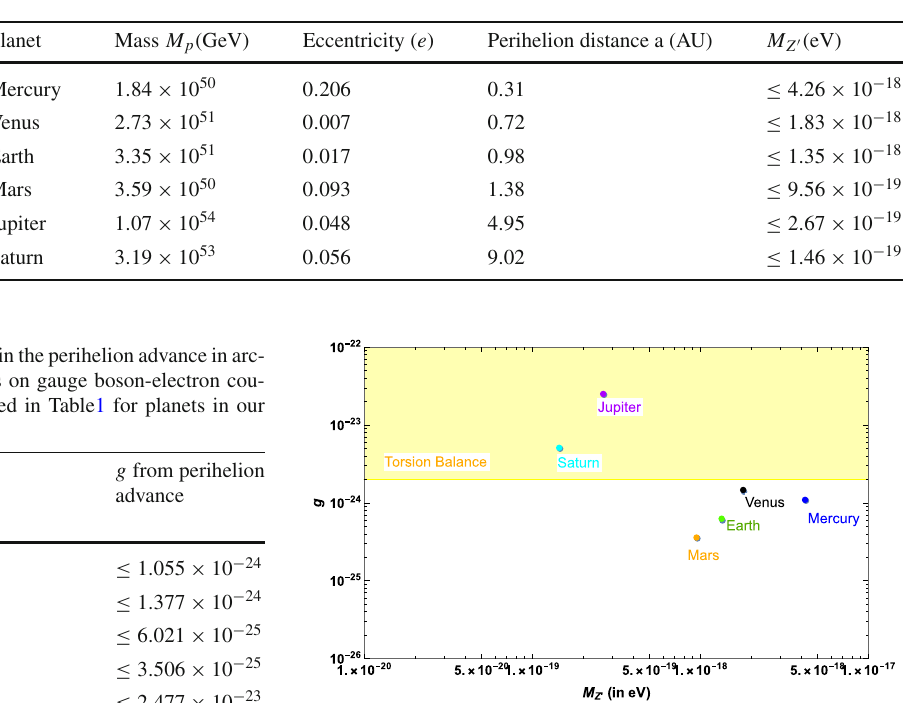
Fig. 2 Values of the gauge coupling of each planets corresponding to the Sun-planet distance obtained from Table2. Violet dot is for Jupiter planet, blue dot is for Mercury planet, black dot is for Venus, cyan dot is for Saturn, green dot is for Earth and yellow dot is for Mars. The yellow 3 Constraints on U ( 1 ) L gauge coupling for shaded region is excluded from the torsion balance e − L μ,τ planets in Solar system